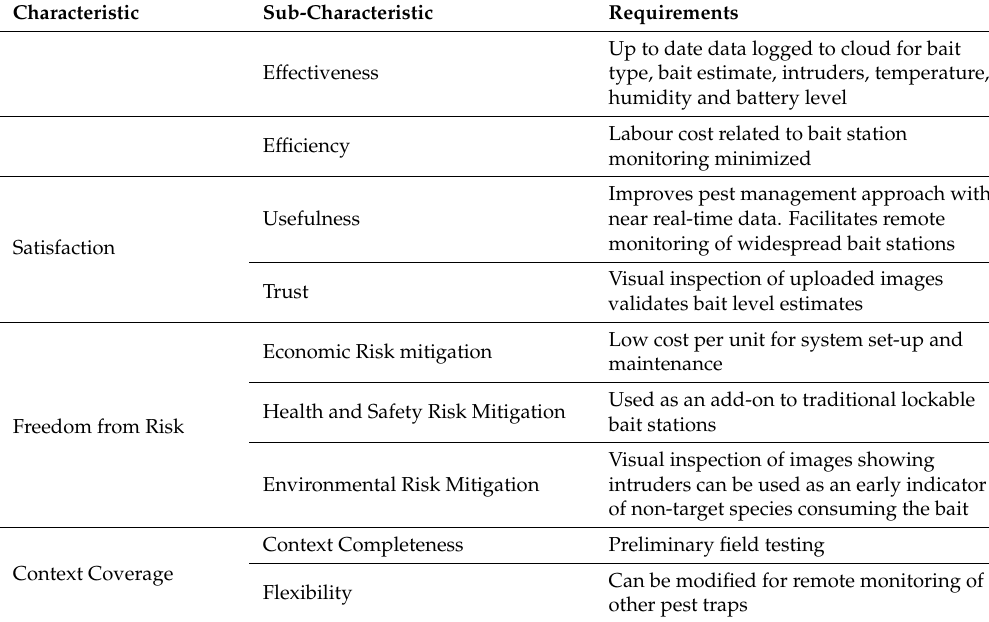
Table 2. Quality in Use